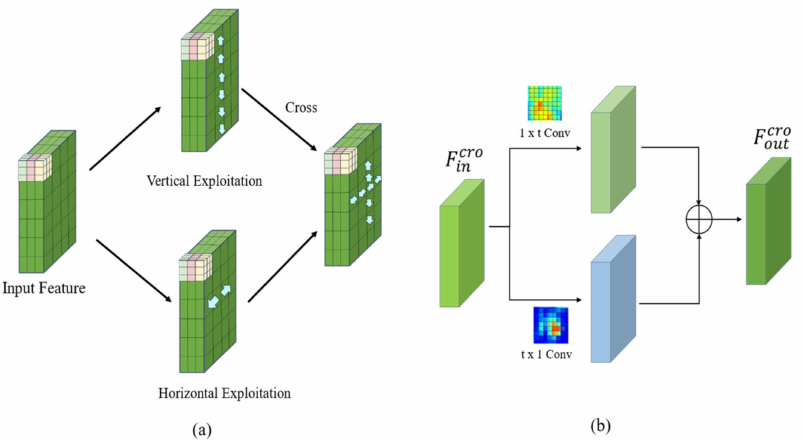
Figure 5. ( a ) Cross-convolution obtains more feature information by taking more information from both horizontal and vertical directions. ( b ) The structure of cross-convolution. F cro represents cross- in convolution input features and F cro represents cross-convolution out features. 1 × t Conv stands for out convolution kernel size of 1 × t . t × 1 Conv stands for convolution kernel size of t ×